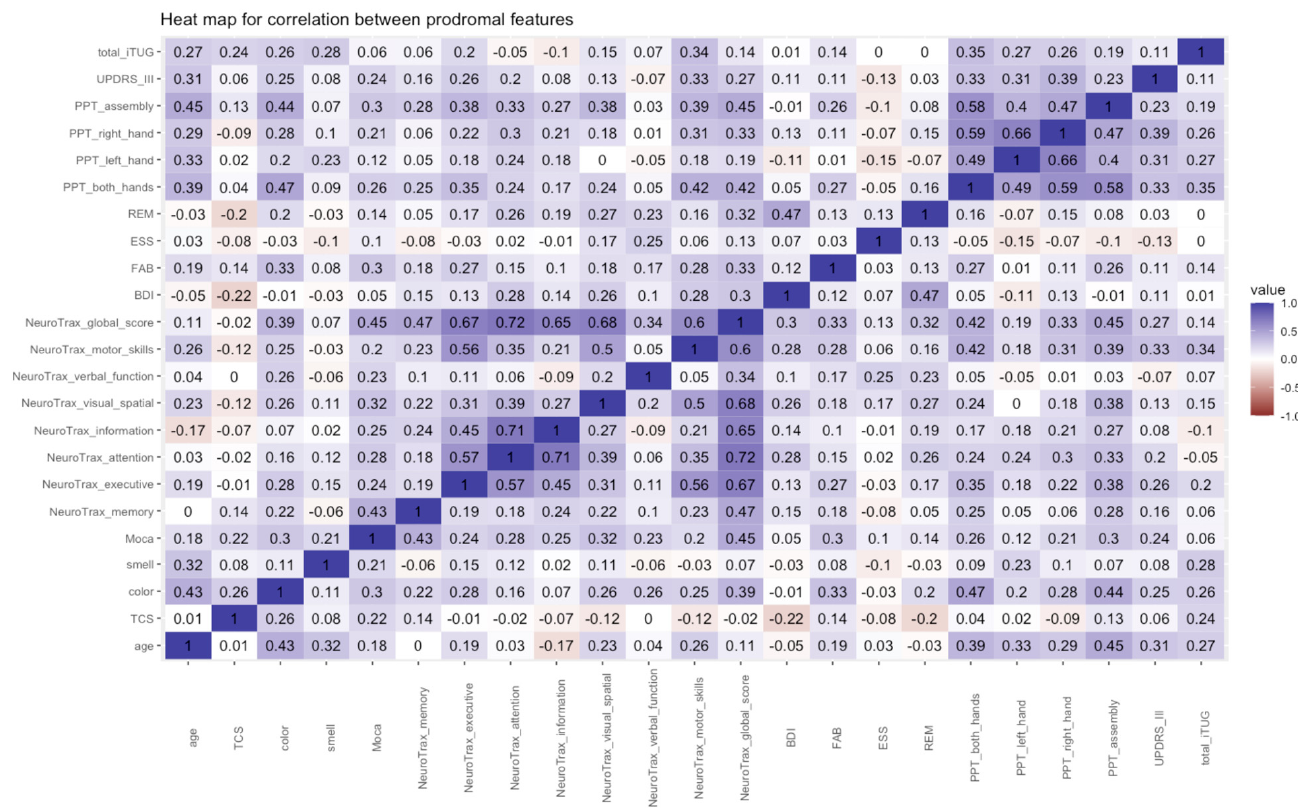
Figure 1. Correlation analysis of prodromal tests lined on a scale from worse to best. Correlation strengths were defined as strong > 0.75, moderate 0.5 − 0.75, weak 0.25 − 0.5 and no relationship < 0.25. TCS, transcranial cranial sonography; BDI, Beck depression innovatory; FAB, frontal assessment battery; ESS, Epworth sleepiness scale; REM, rapid eye movement, PPT, Perdue pegboard test; iTUG, Timed Up and Table 4. Percentage of “abnormal” tests according to GBA1 variant.